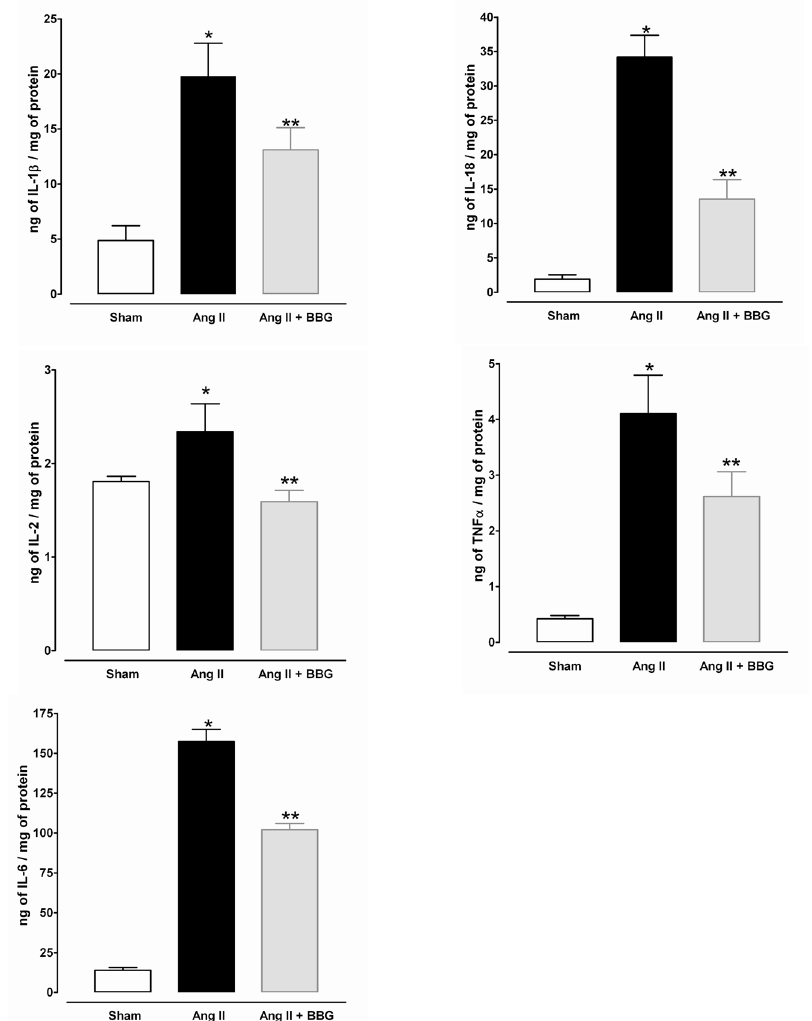
Figure 7. Interleukins IL-1 β , IL-2, IL-6, IL-18 and TNF α in the renal cortical tissue from Sham, Ang II and Ang II + BBG, ( n = 7 per group). * p < 0.001 vs. Sham, ** p < 0.05 vs. Ang II. Ang II = angiotensin II; BBG = brilliant blue G.